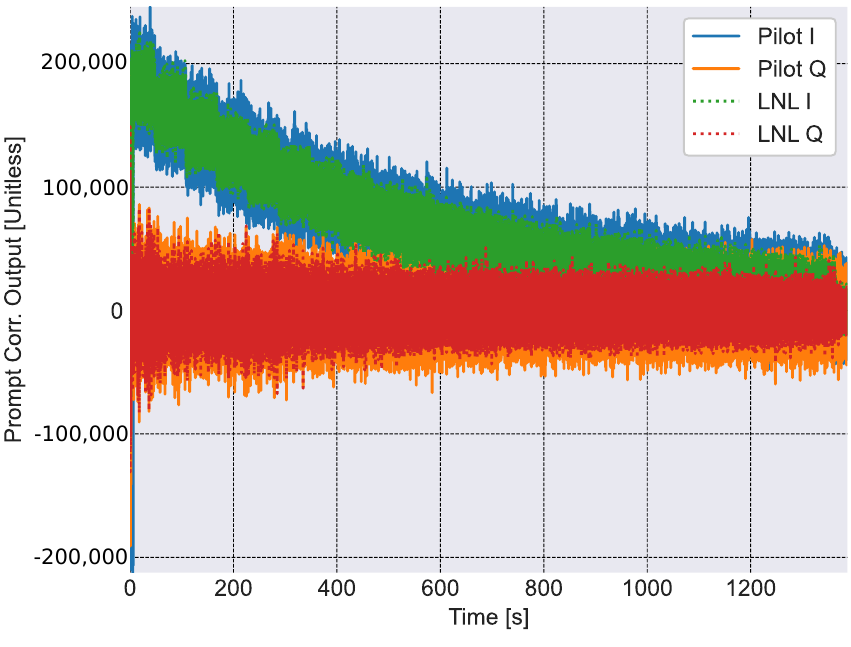
Figure 7. Comparison between the pure pilot and LNL correlators obtained for the different epochs of the experiment. A single non-coherent integration is